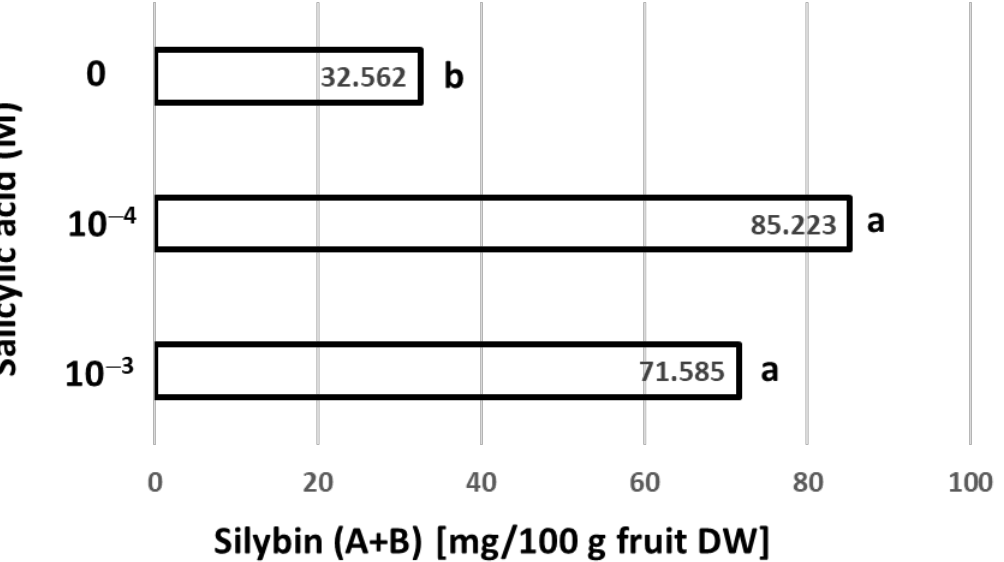
Figure 1. The contents of silybin (A + B) (mg/100 g fruit DW) in S. marianum L fruit. The means with the same letter are not statistically different at p ≤ 0.05.